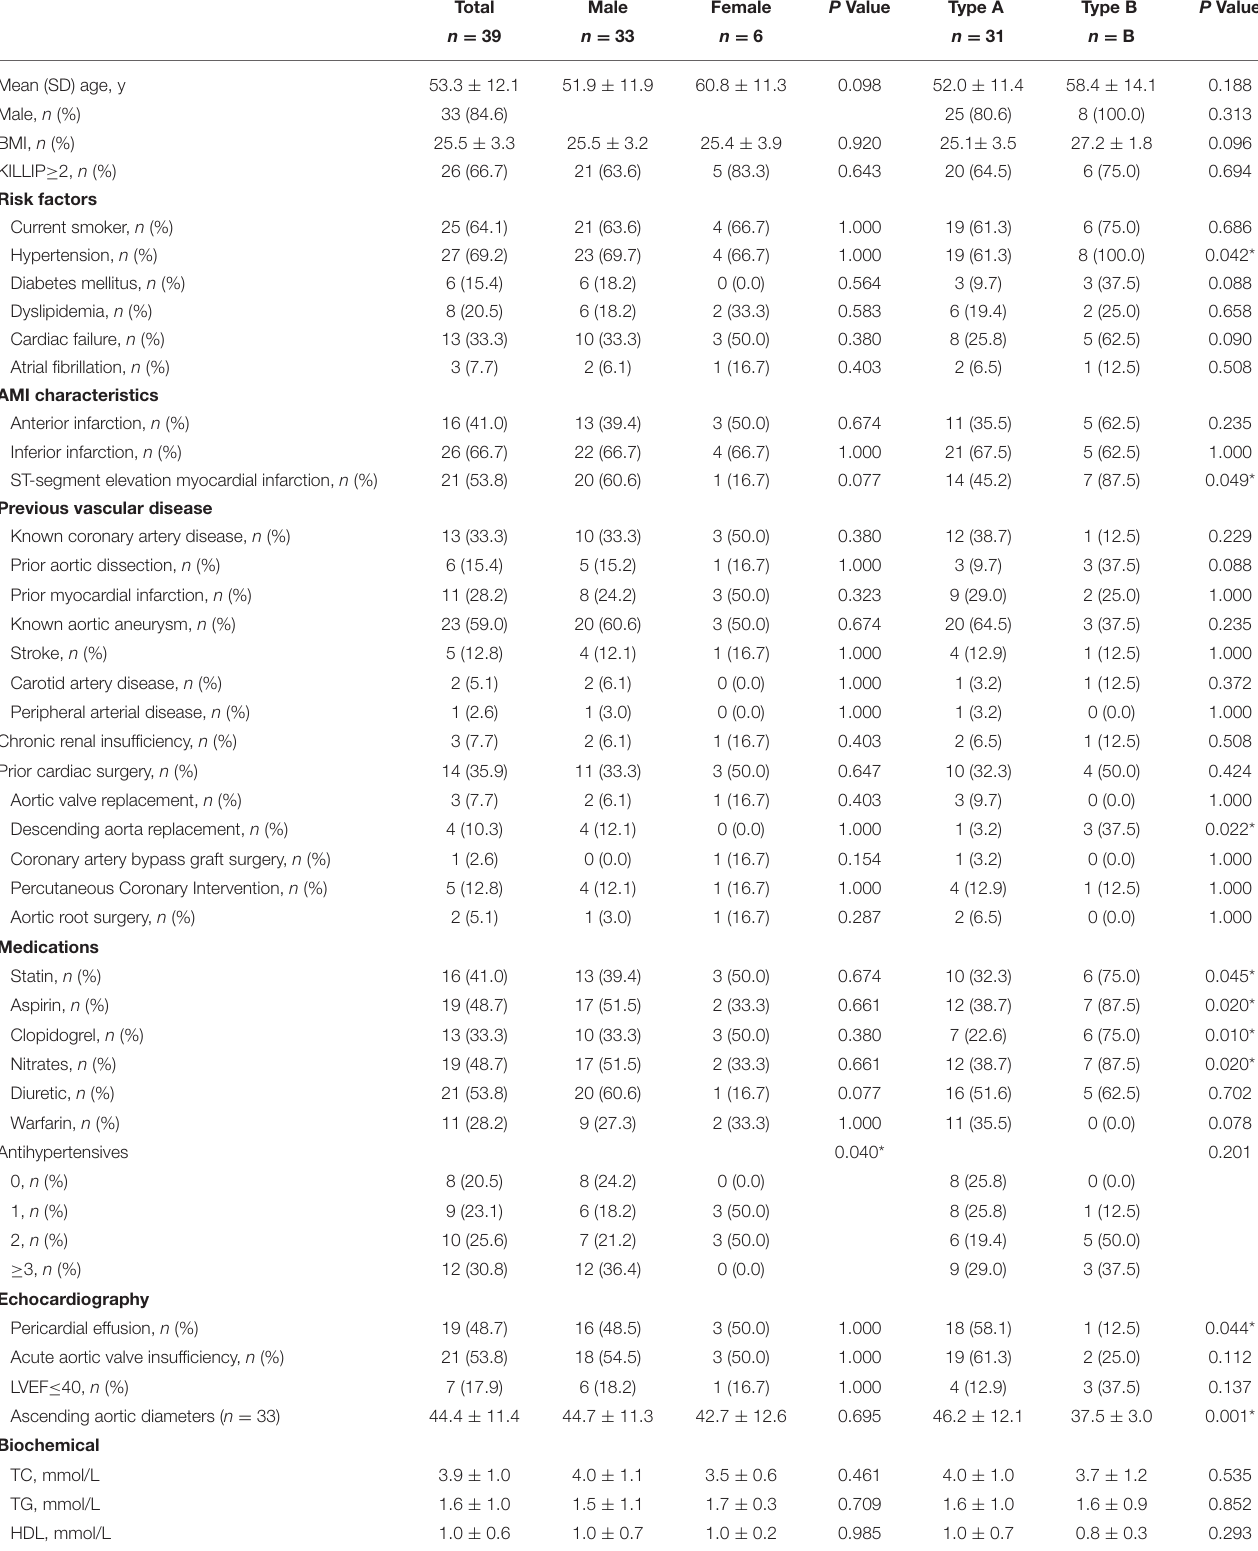
TABLE 1 | Demographics and risk factors for incident aortic dissection by sex and